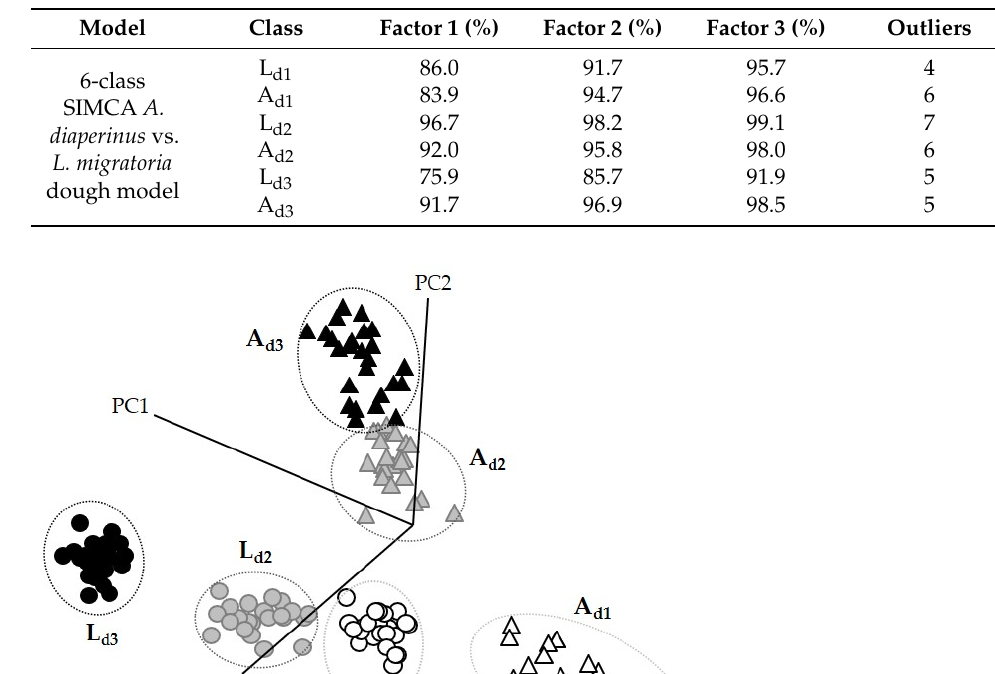
Table 6. The number of factors, their cumulative variance, and the number of outliers used to create a 6-class SIMCA model of A. diaperinus vs. L. migratoria dough.